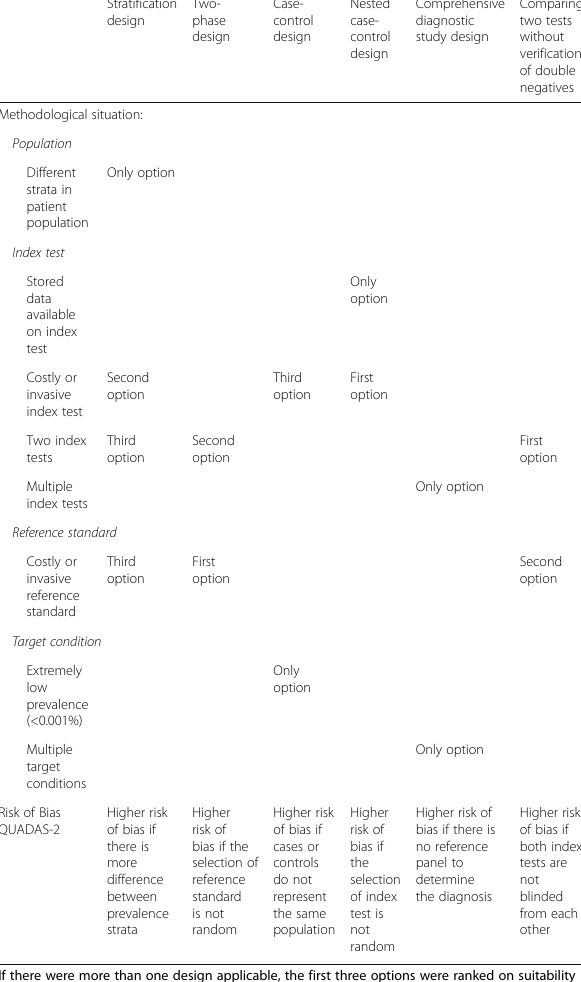
Table 1 (abstract O11). Summary of design ranking in different methodological